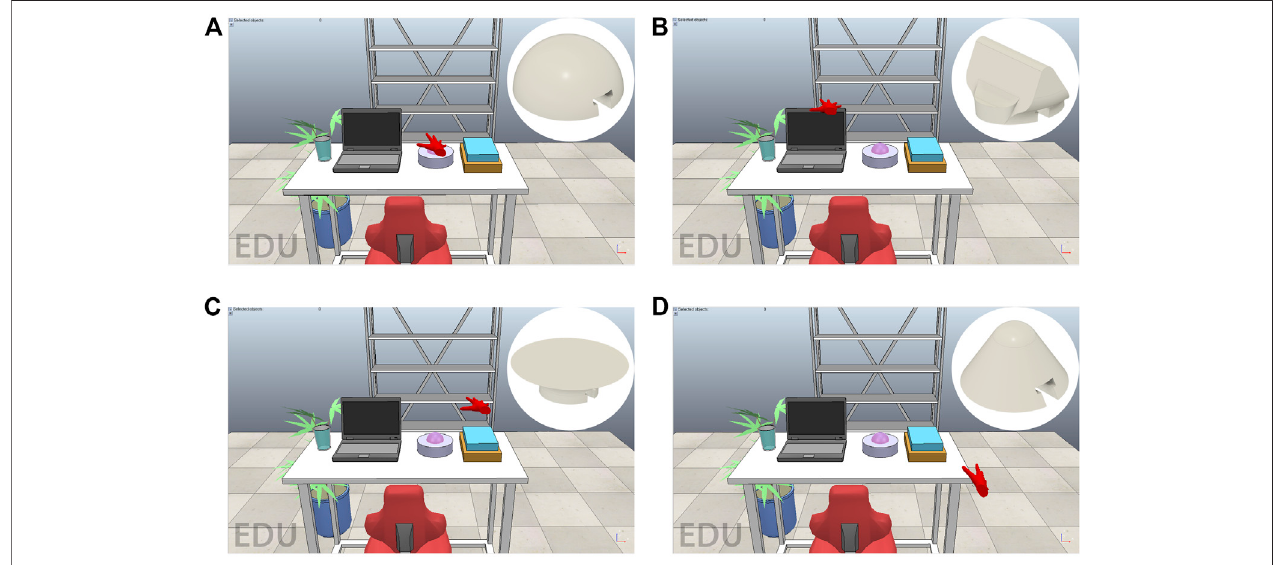
FIGURE9 | The testing virtual scenarioiscomposed ofarack and aplant in vasein backgroundand anof fi ce station inthe foreground. The interaction is provided by the red hand avatar of and the objects in foreground are chosen to use all modules: paperweight for H1 module (A) ; laptop frames for H2 module (B) ; cover of book and the surface of desk for H3 module (C) ; and desk, laptop, and book peaks for H4 module (D) .